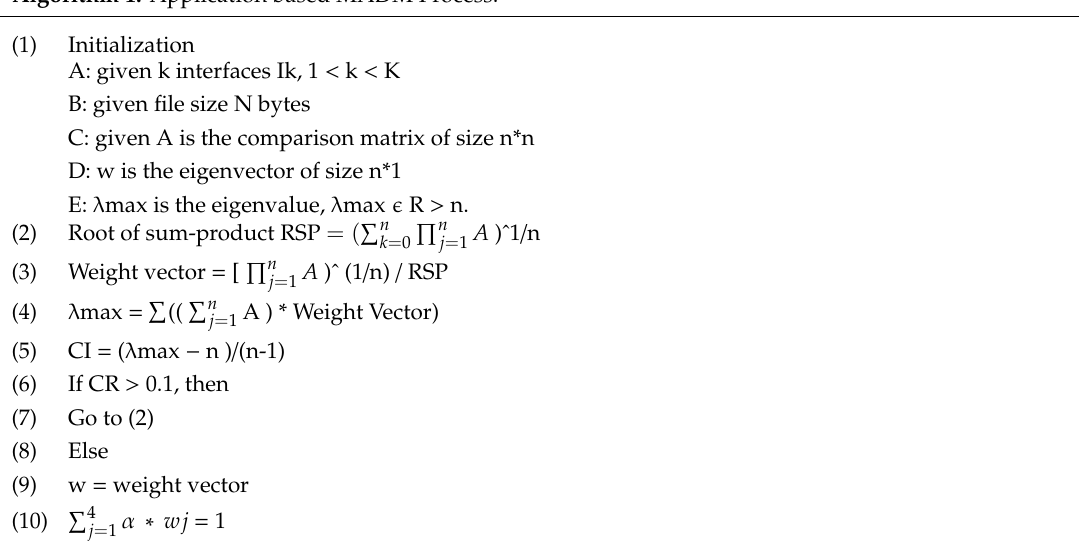
Algorithm 1: Application based MADM Process.